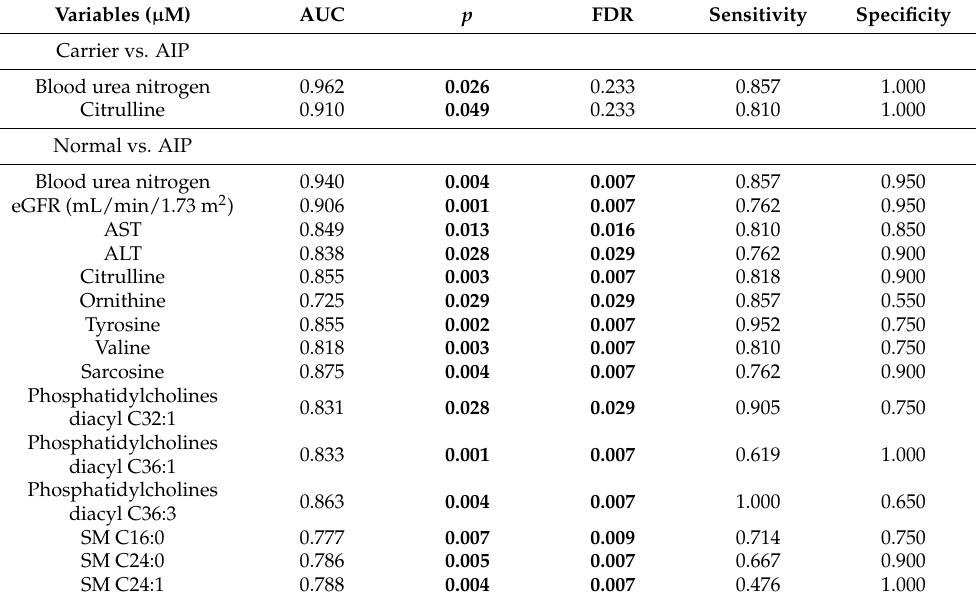
Figure 2. Clinical variables and metabolite levels differed significantly between normal, asymptomatic carriers, and AIP patients. Statistical differences were determined by one-way ANOVA, and data are presented as minimum, first quartile, third quartile, and maximum (line, median value; diamond, mean value; circle, outlier value) in box-and-whisker plots. Pair- wise comparison was executed using Dunn’s post hoc test. ( A ) Amino acids; ( B ) Sphingomyelins; ( C ) Glycerophospholipids; ( D ) Kidney function, urea cycle, and other serum markers. * p < 0.05 for Dunn’s post hoc test. Table 2. Variables identified by AUC analysis as distinguishing AIP patients from asymptomatic carriers and from normal